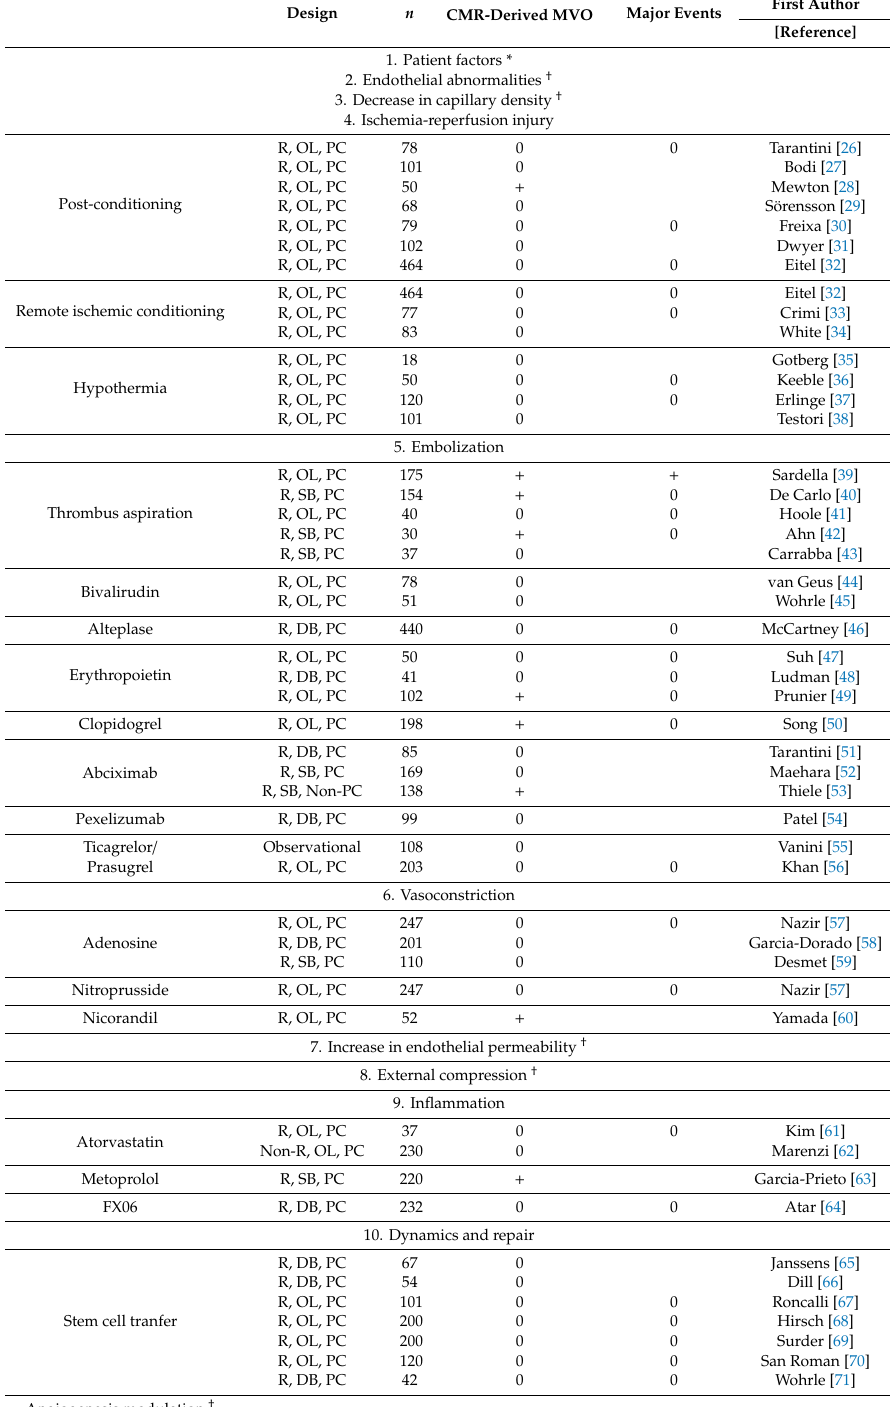
Table 1. The main clinical studies and clinical trials to evaluate the e ff ect of di ff erent therapies in cardiovascular magnetic resonance (CMR)-derived microvascular obstruction (MVO) and major events (death and / or re-infarction), classified according to the pathophysiological factors